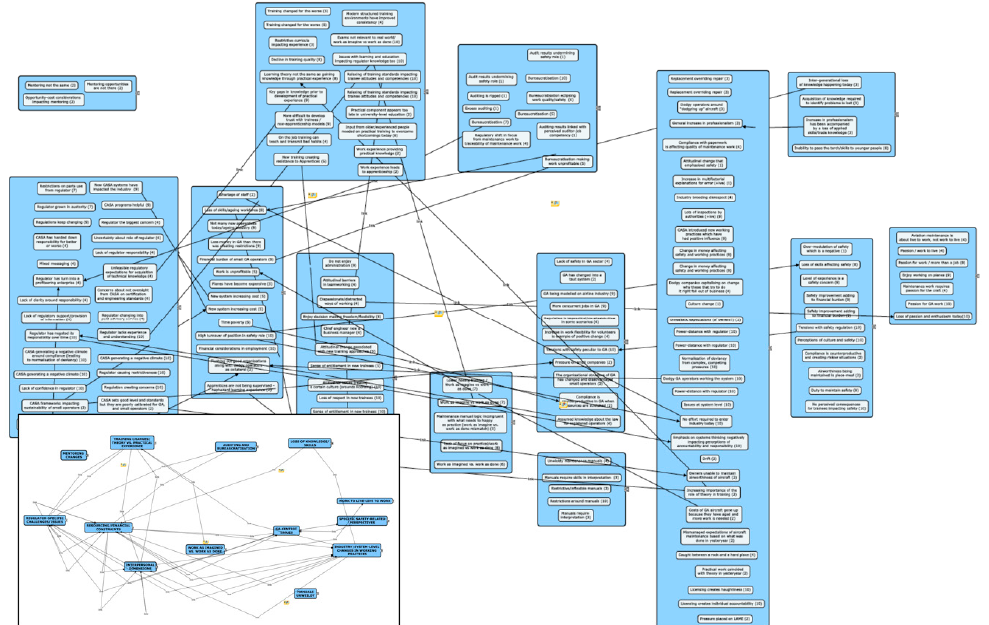
Figure 3. Illustration of concepting mapping of coded data in CmapTools. The large screenshot depicts arrangement of data midway through Steps 2 and 3 (axial and selective coding) and the inset (bottom-left) highlights connections between meaning units across thematic groupings in a collapsed form. Note: writing in picture is designed to provide an overview and is intentionally illegible.